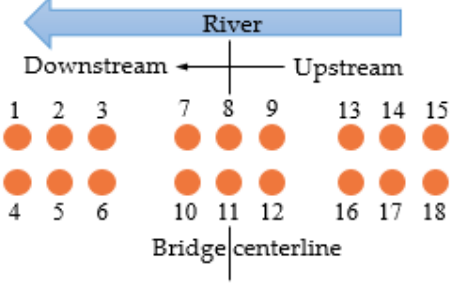
Figure 14. Location and number of steel pipe columns of the tower at the right bank.